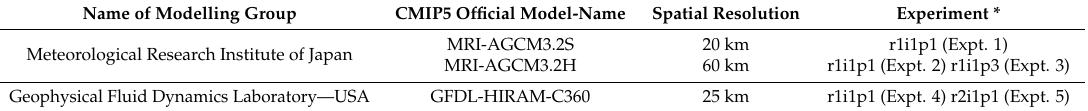
Table 1. Selected CMIP5 high-resolution climate models and experiments.